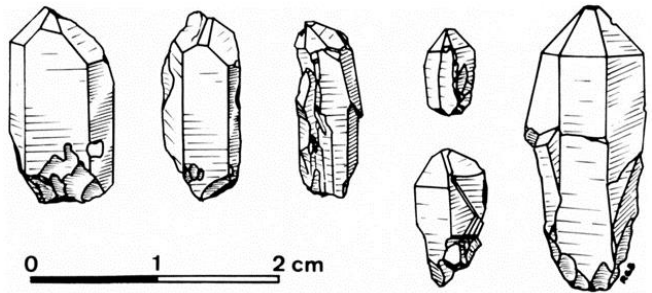
Figure 18. Small quartz crystals from Singi Talav, Rajasthan, India, which are manuports of the Lower